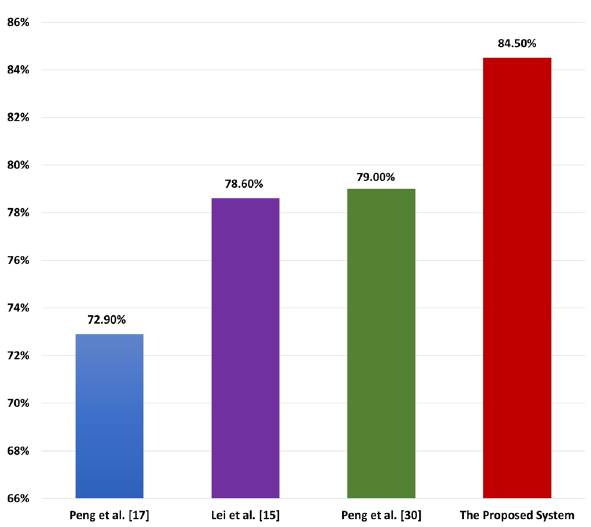
Figure 11. The comparison between our proposed system and some current studies based on